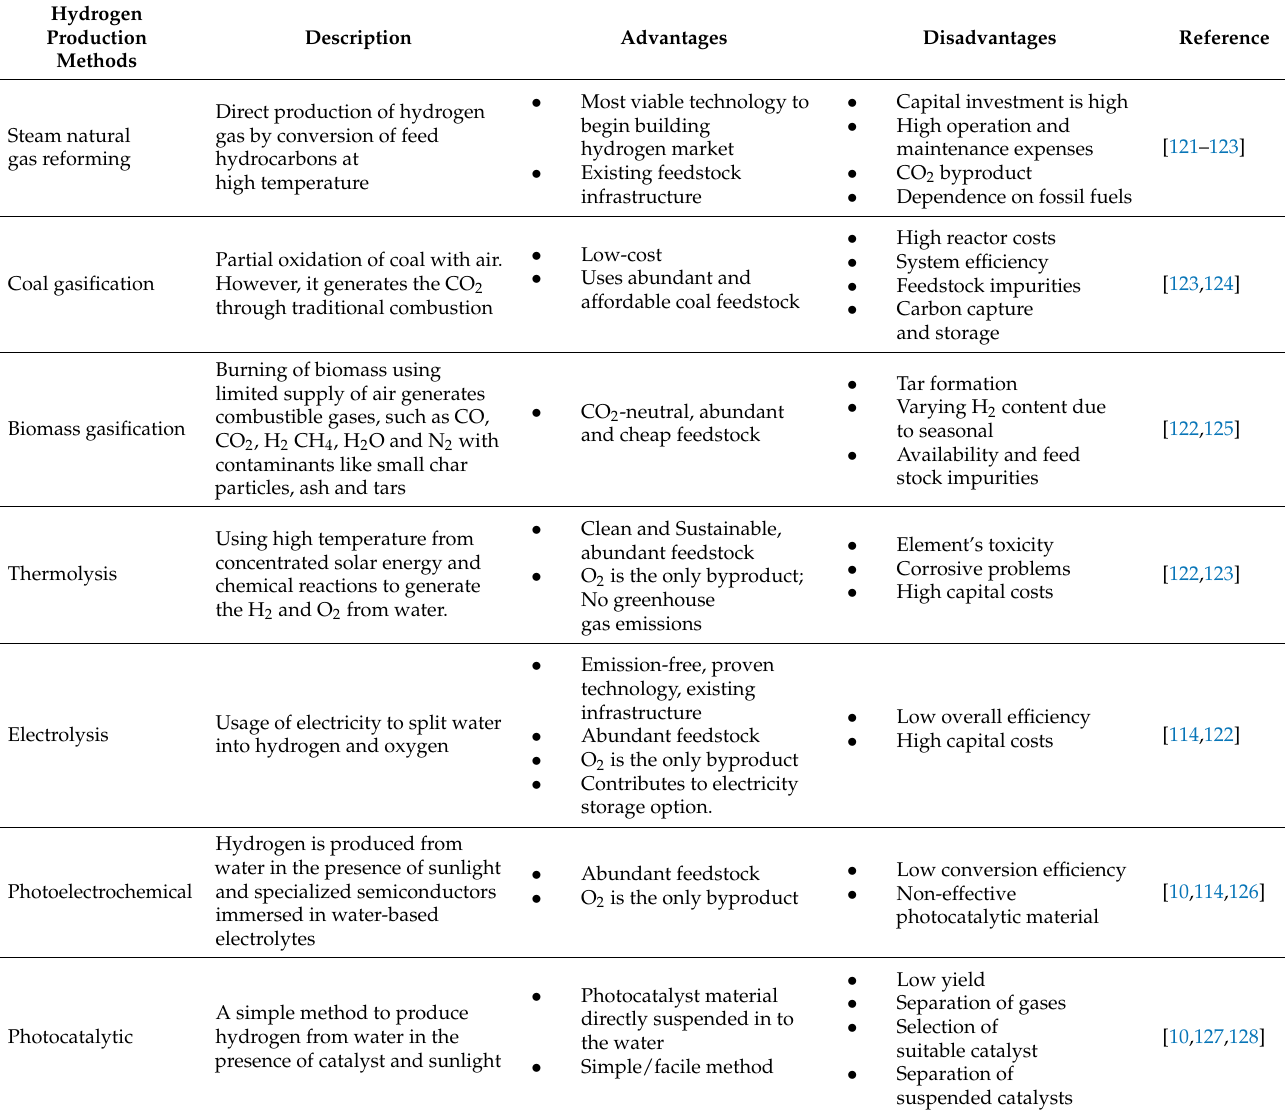
Table 2. Different hydrogen production methods and its advantages and